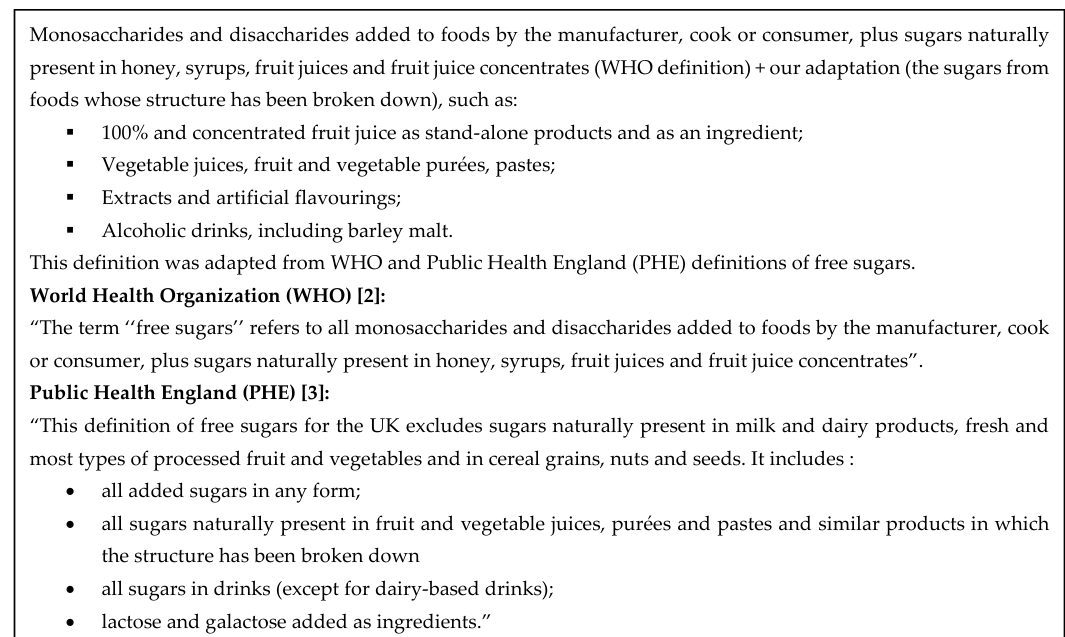
Figure 1. Free sugars definition used in this